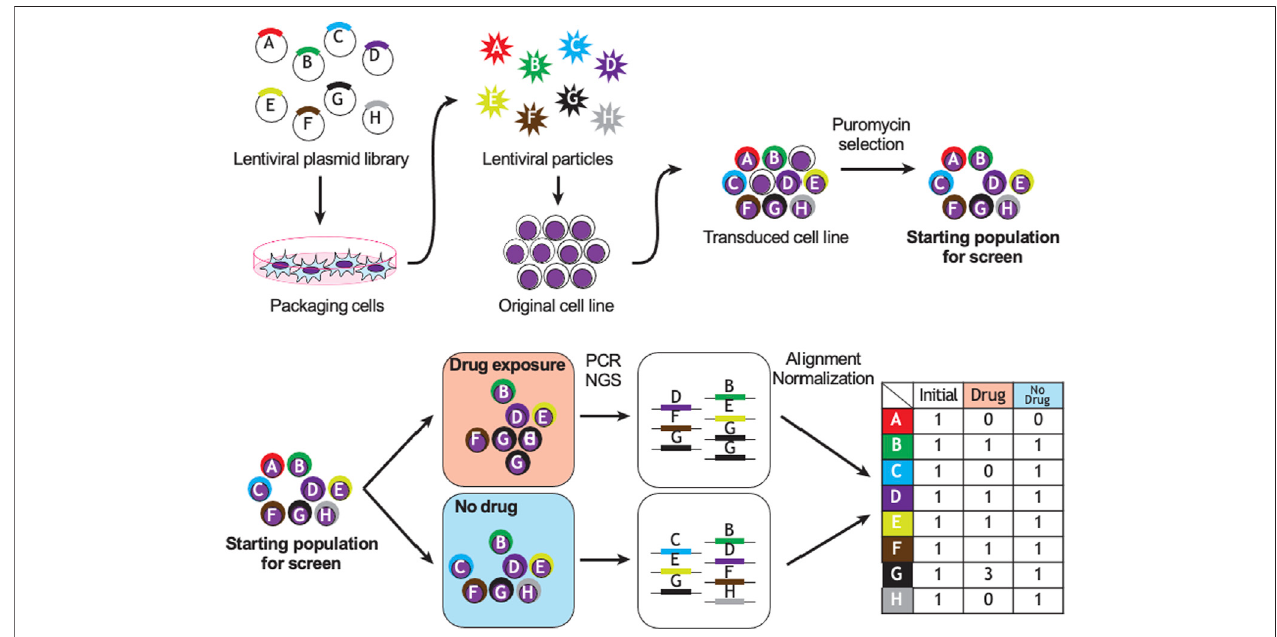
FIGURE 2 | Example of CRISPR or shRNA pharmacogenomic screen. Sequence A targets a gene essential to cell survival; B, D, E, F are biologically neutral; G promotes drug resistance and C and H promote drug sensitivity. PCR: polymerase chain reaction, NGS: next-generation sequencing.